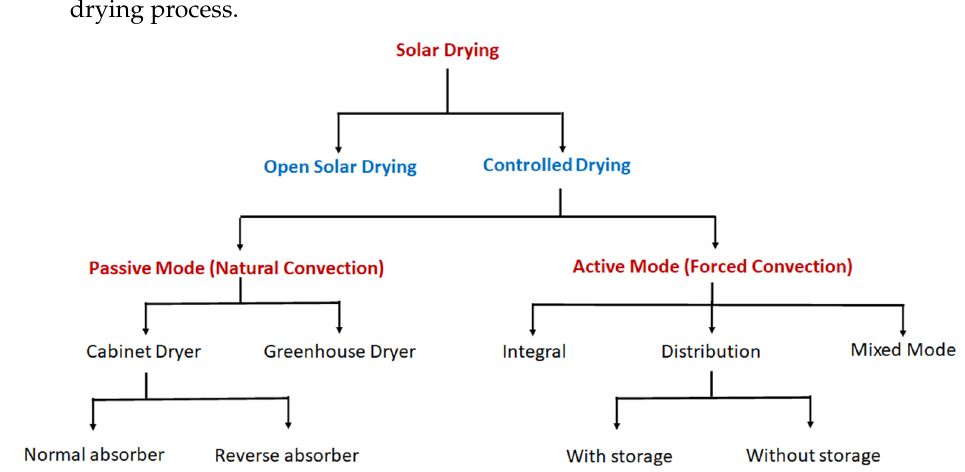
Figure 5. A general classification of solar dryers.